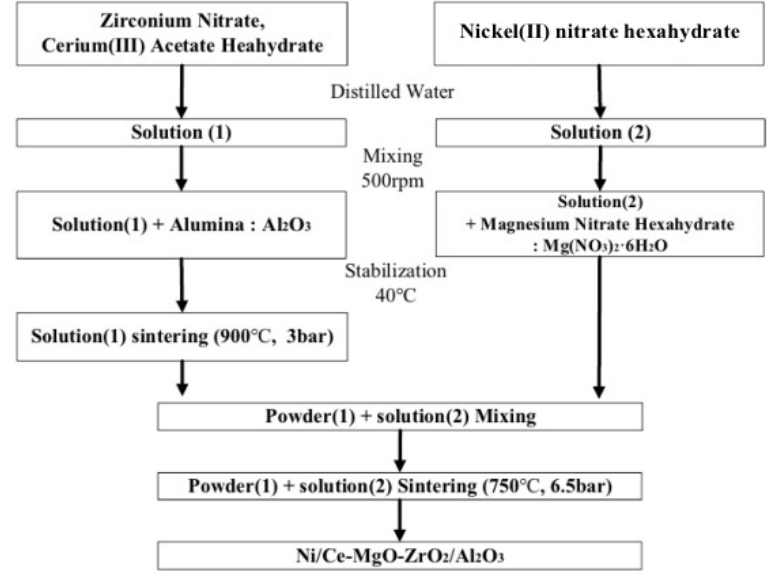
Figure 5. Preparation of the 3 wt% Ni-catalyst .